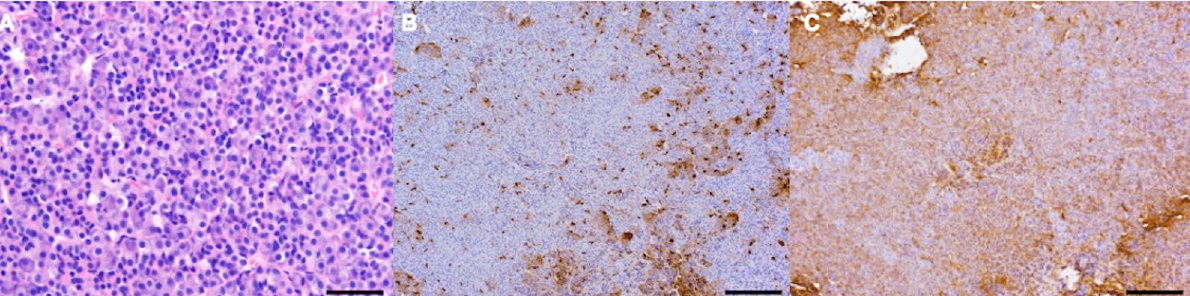
Figure 4. Histopathological examination. Hematoxylin and eosin staining showing the resected anterior pituitary gland (bar = 50 µm). ( A ) The tissue is detected as the immunopositive area using anti- adrenocorticotropic hormone staining ( B ) and anti-growth hormone ( C ) staining (bar = 200 µm).